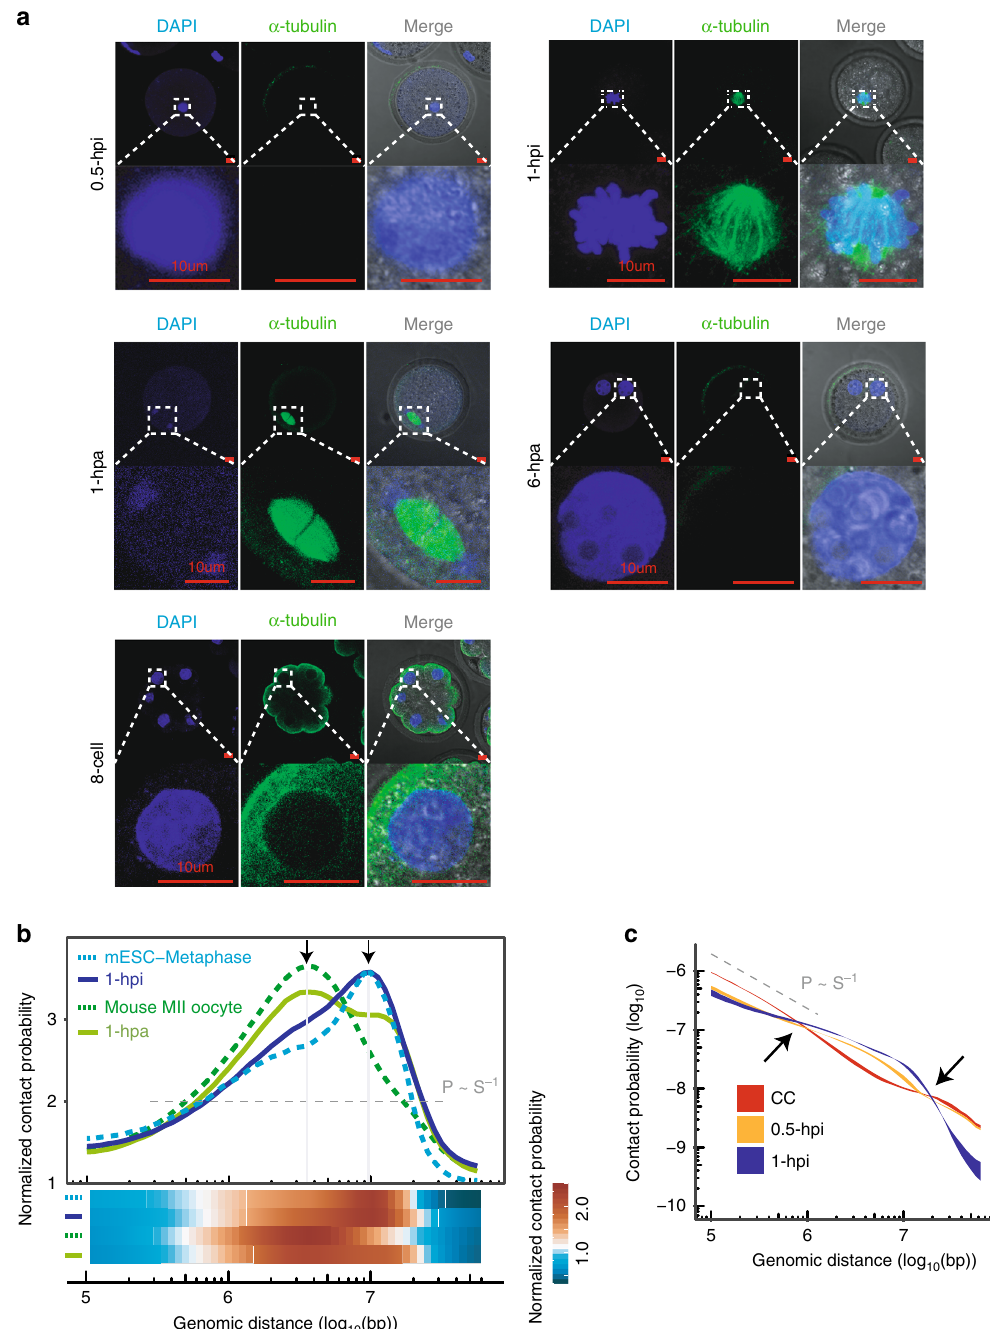
Fig. 2 Mitotic metaphase to meiosis metaphase II-like chromatin transition. a Immuno fl uorescence staining of 0.5-hpi, 1-hpi, 1-hpa and 6-hpa 1-cell embryos and 8-cell embryos. DNA: DAPI (blue) and microtubules: α -tubulin (green). Scale bar: 10 μ m. Data are representative of three independent experiments. b Both the curves and heatmaps showing the intrachromosomal interaction probabilities ( P(s) ) relative to genomic distance that are normalized by the P(s) ~ s − 1 values. The peaks represent the rapid fall-off at ~4 Mb and ~10 Mb in secondary meiotic and mitotic chromatin, respectively. Source data are provided as a Source Data fi le. c The chromatin contact probabilities ( P(s) ) relative to genomic distance for CC, 0.5-hpi, and 1-hpi embryos. The P(s) ~ s − 1 curve representing the predicted fractal globule state is shown for reference. The P(s) ribbon is bounded by minimum and maximum ( P(s) ) calculated from all replicates of Hi-C data sets. Source data are provided as a Source Data fi